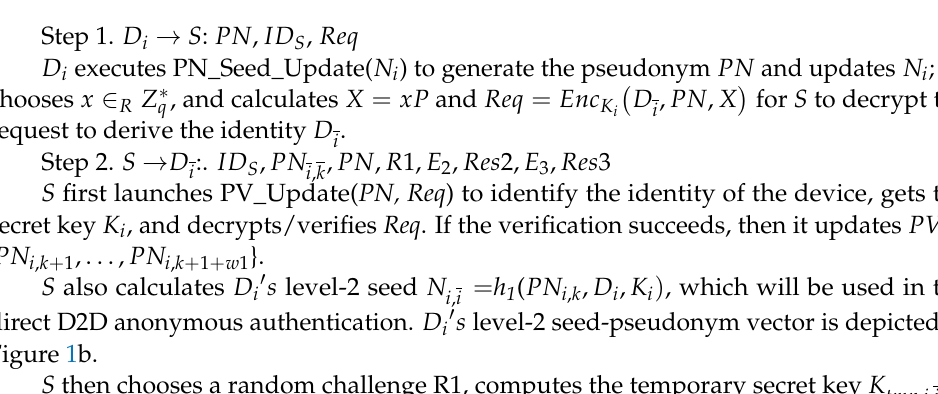
Figure 5. S-assist-once-a-while D2S2D anonymous